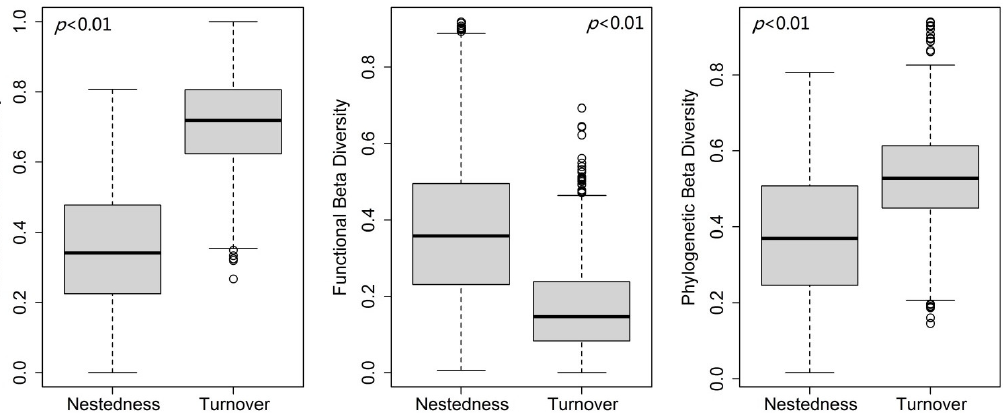
Figure 2. Results of the paired t -test of taxonomic nestedness against taxonomic turnover, functional nestedness against functional turnover, and phylogenetic nestedness against phylogenetic turnover. Taxonomic and phylogenetic turnover was significantly higher than their nestedness components. In contrast, functional turnover was significantly lower than functional nestedness. The circles in the figure were some extreme values.